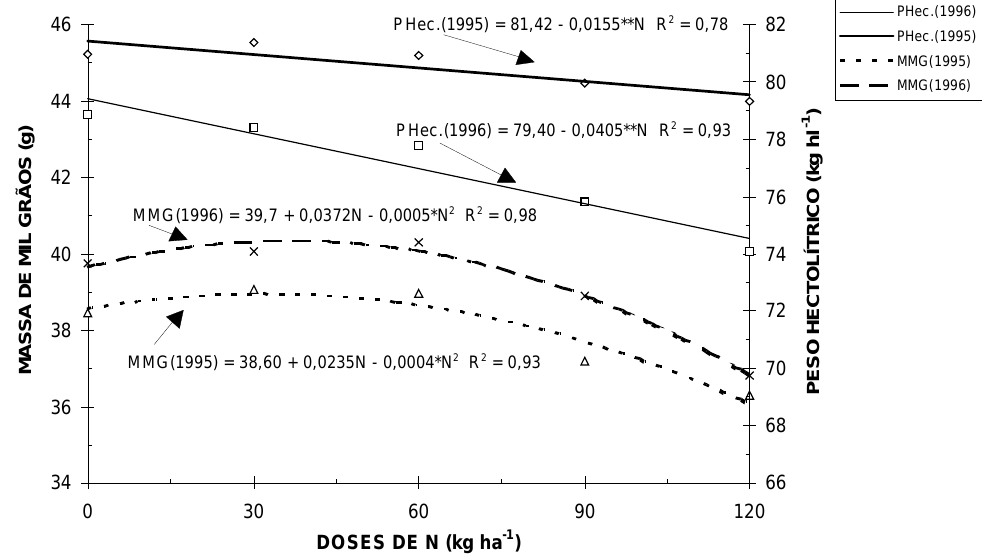
Figura 2. Massa de mil grãos (MMG) e peso hectolítrico (PHec.) de trigo influenciados pelas doses de nitrogênio (N) em cobertura, em 1995 e